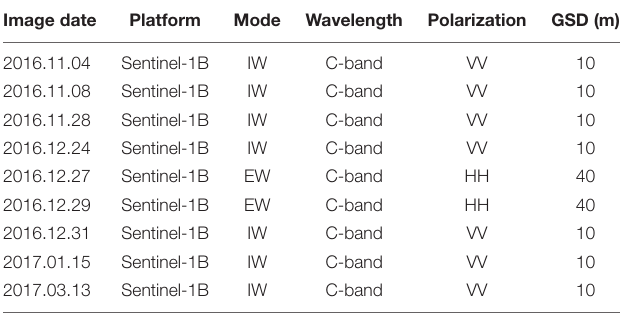
TABLE 1 | Selected synthetic aperture radar datasets used to identify changes to sea ice conditions around the time of the